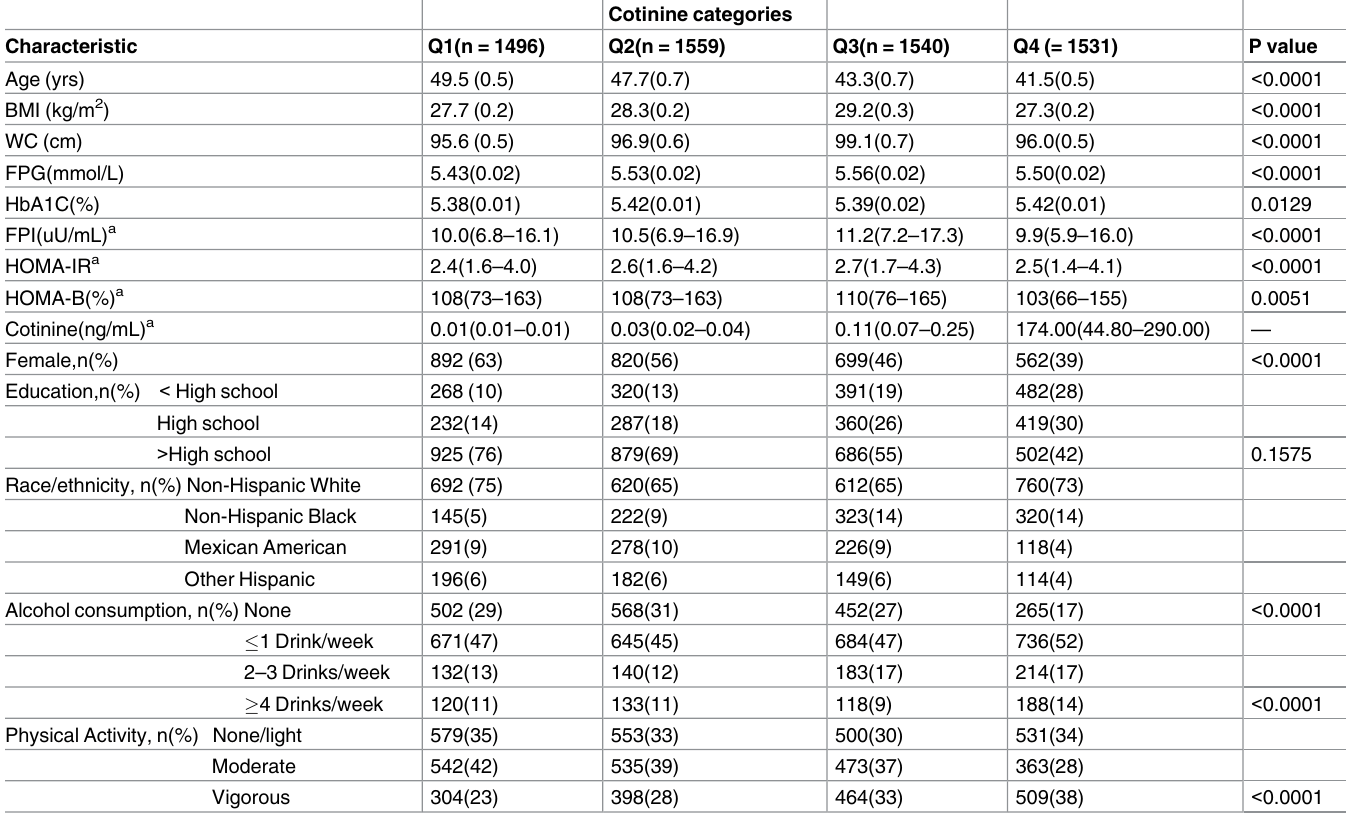
Table 1. Characteristics of adult participants without diabetes in NHANES 2007–2012 by cotinine